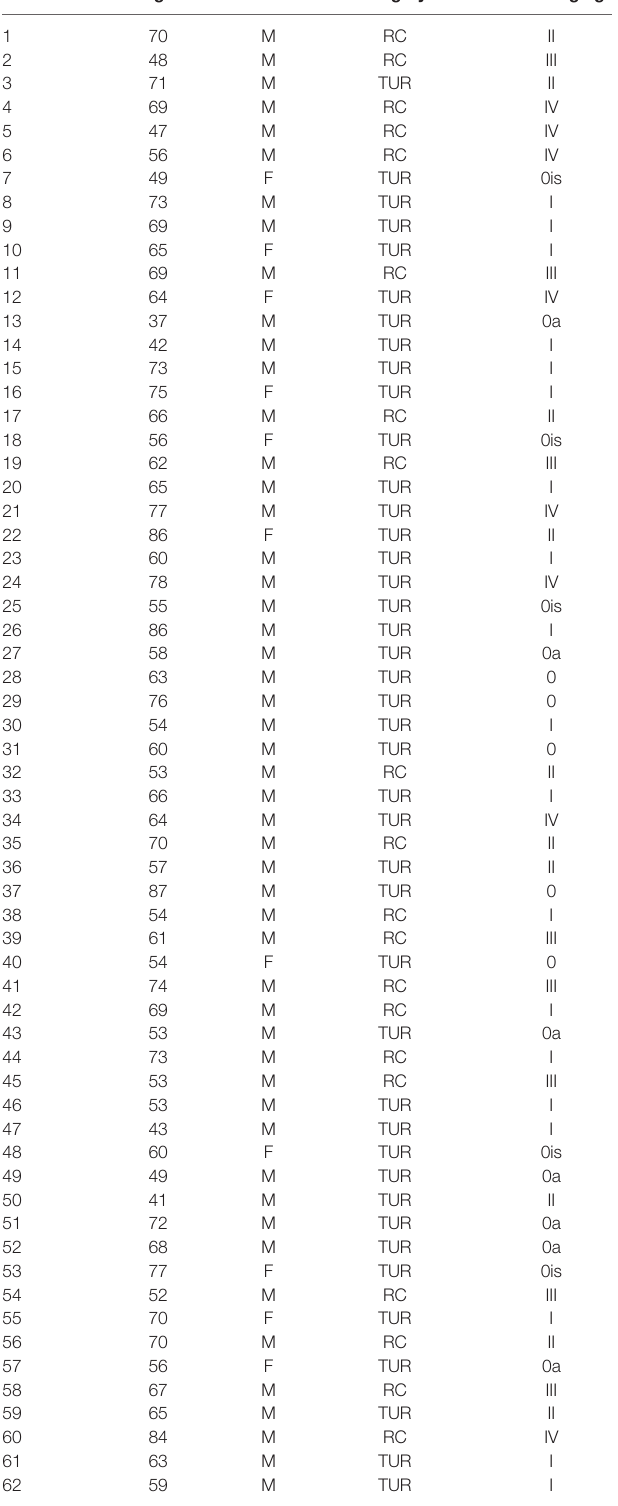
TABLE 1 | Clinical-pathological information of 85 bladder carcinoma (BLCA) patients in this study. Case